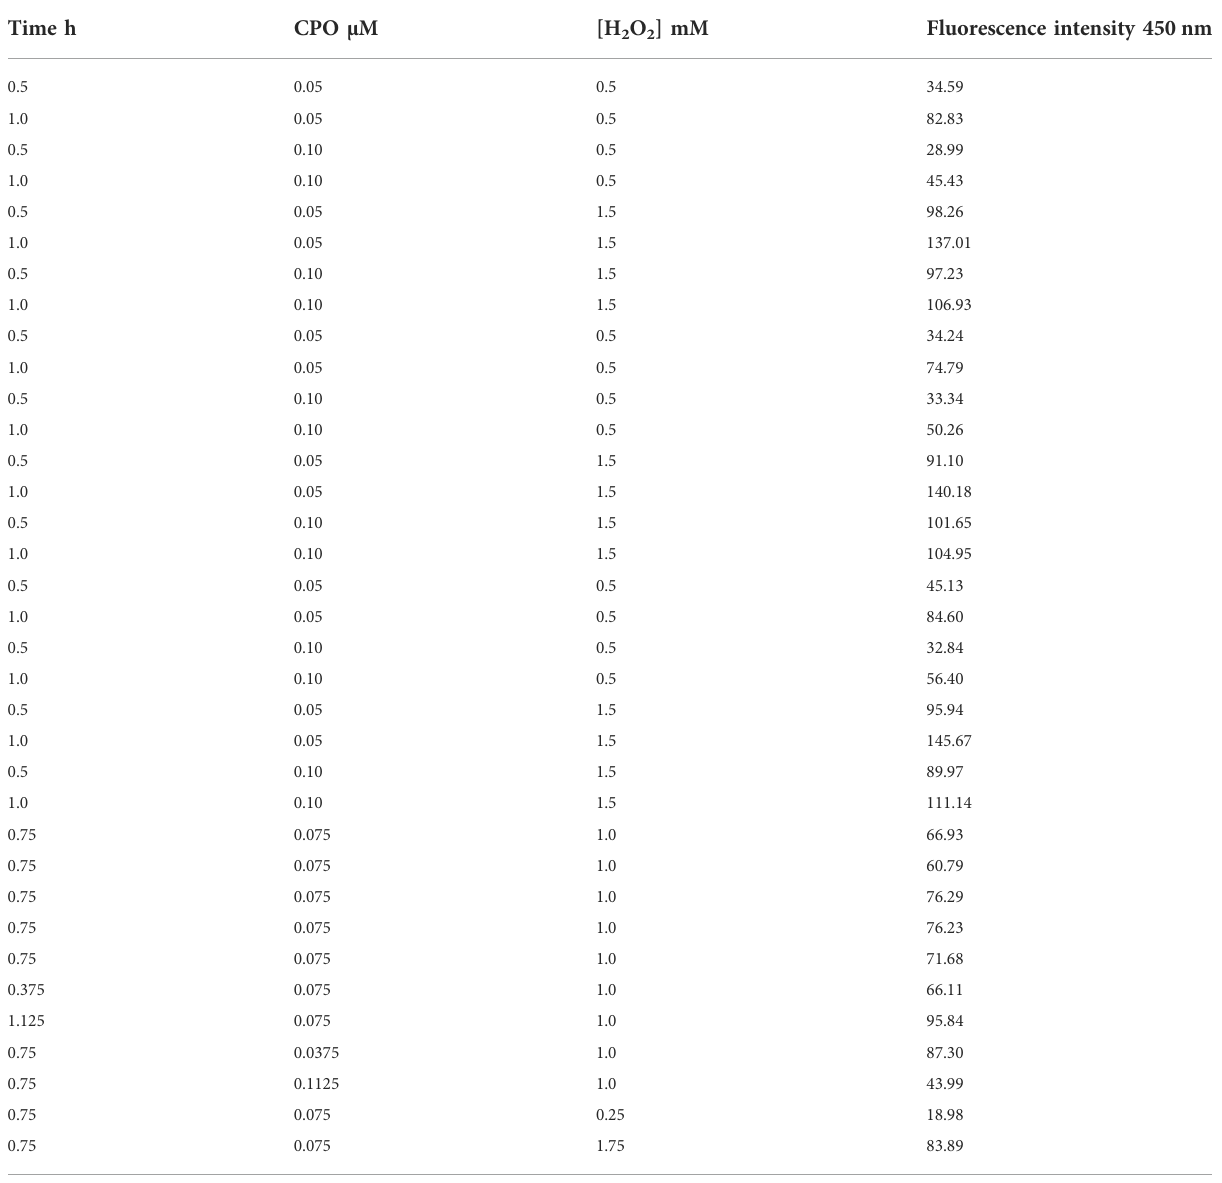
TABLE 2 Central Composite Design for ampicillin oxidation by